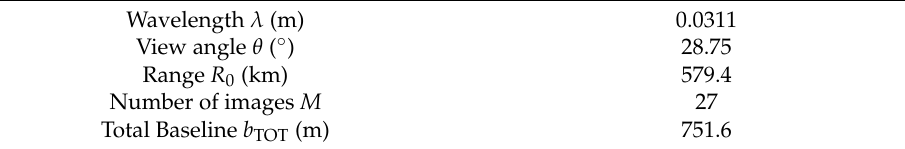
Table 2. TSX Configuration